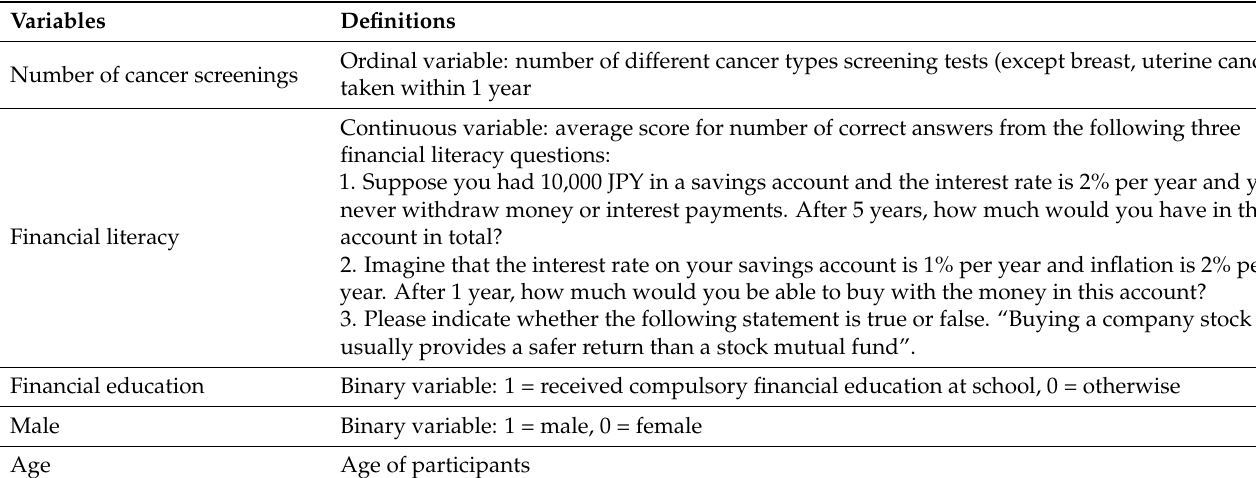
Table 1. Variable